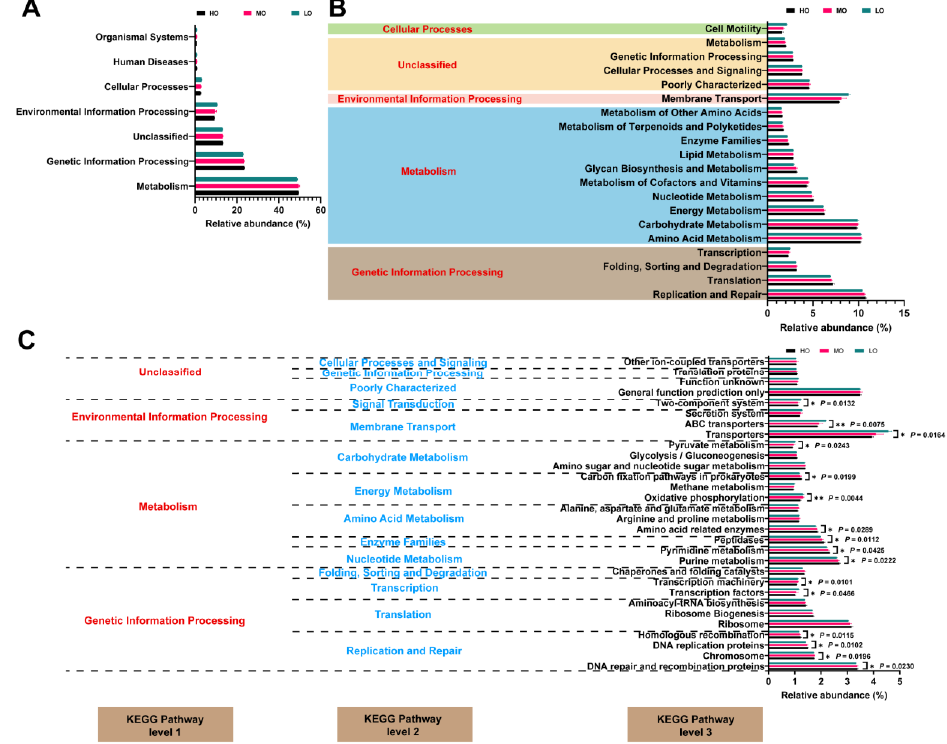
Figure 4. Dynamics of rumen bacterial predicted functional profiles fed with different diets analyzed by PICRUSt2 ( n = 3). ( A ) Level 1 metabolic pathways. ( B ) Level 2 Kyoto Encyclopedia of Genes and Genomes (KEGG) ortholog functional predictions of the relative abundances of the top 20 metabolic functions. ( C ) Level 3 KEGG ortholog functional predictions of the relative abundances of the top 30 metabolic functions. LO, low oat percentages group; MO, medium oat percentages group; HO, high oat percentages